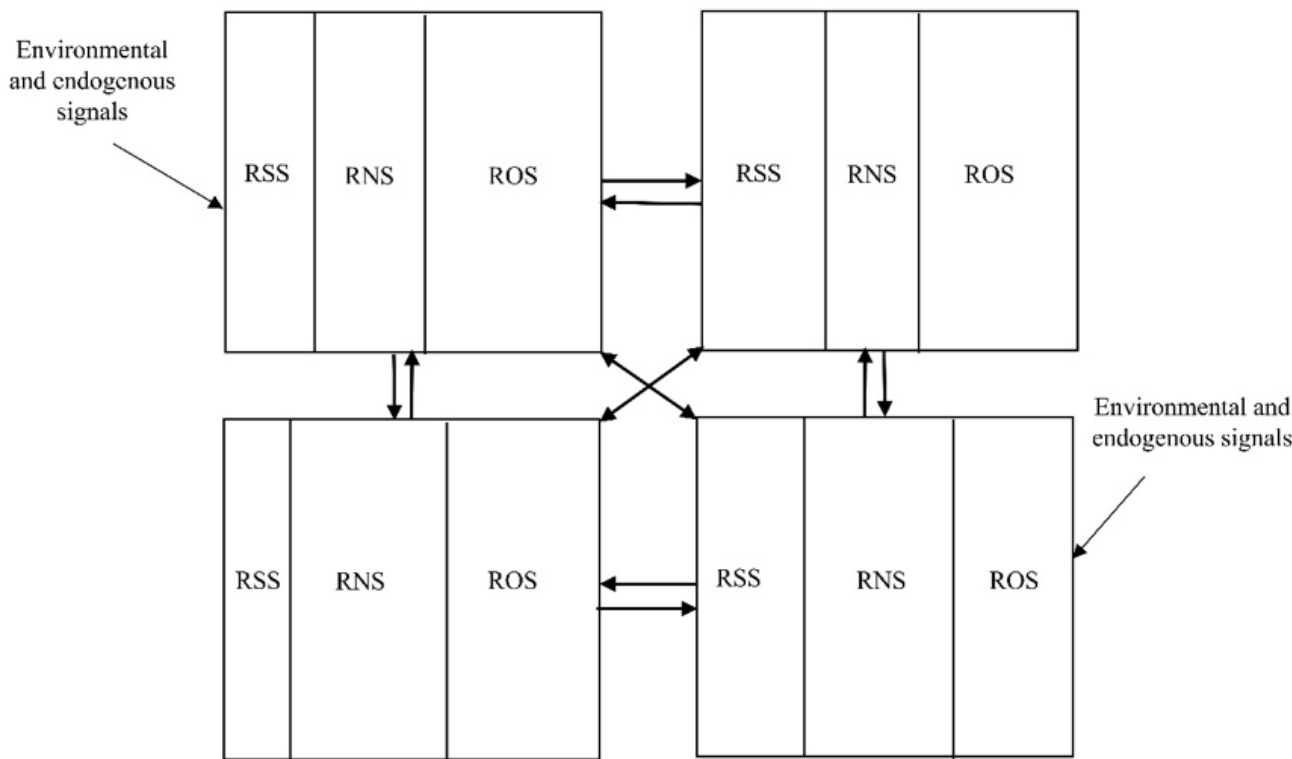
Figure 6. The dynamic balance in the relative amount of RSS, RNS, and ROS molecules is represented. In addition to the modifications of the RSS, RNS, and ROS species profiles, each change in the balance between the relative quantities (redoxtasis) would imply adjustments in the phenotype (transcriptome, proteome, metabolome, etc.) of the plant. The changes would be responses to external environmental signals, such as temperature and irradiance, and endogenous signals from the organism